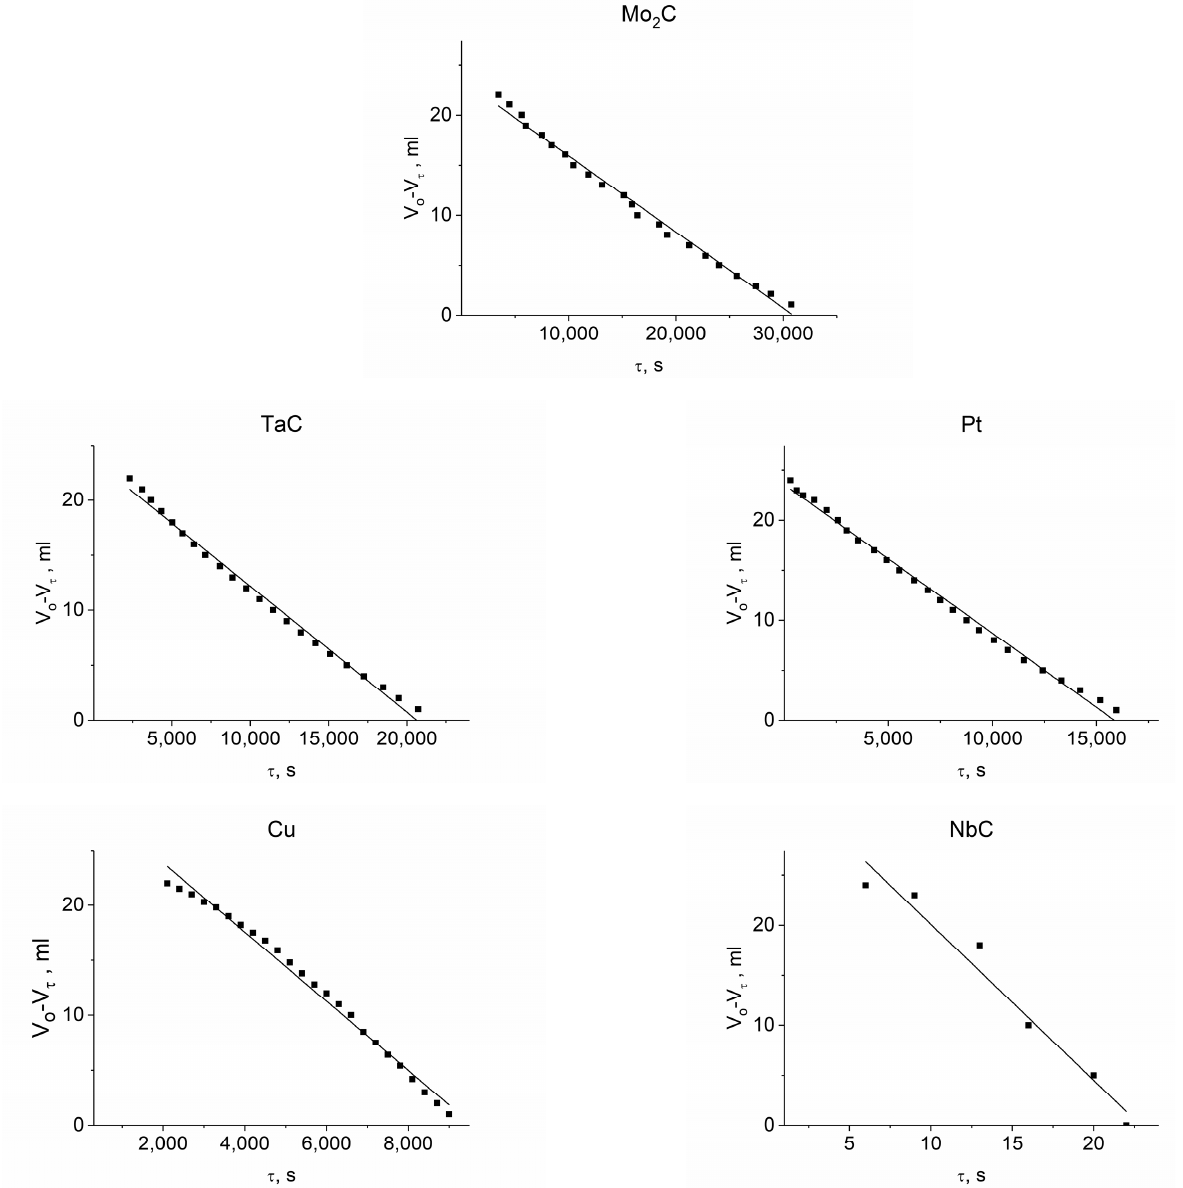
Figure 13. Zero-order kinetic dependencies of the electrocatalytic decomposition of H 2 O 2 , taken on the electrodes at the same temperature 303 K.